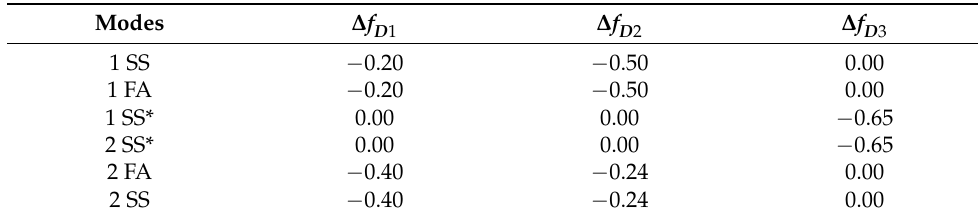
Table 2. Variation of the natural frequencies associated with tested damage scenarios